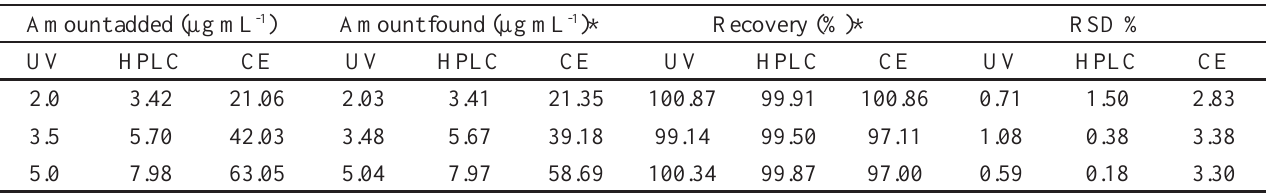
TABLE III - Accuracy data (recovery studies) of UV, HPLC and MEKC methods for quantification of hydrochloride raloxifene in